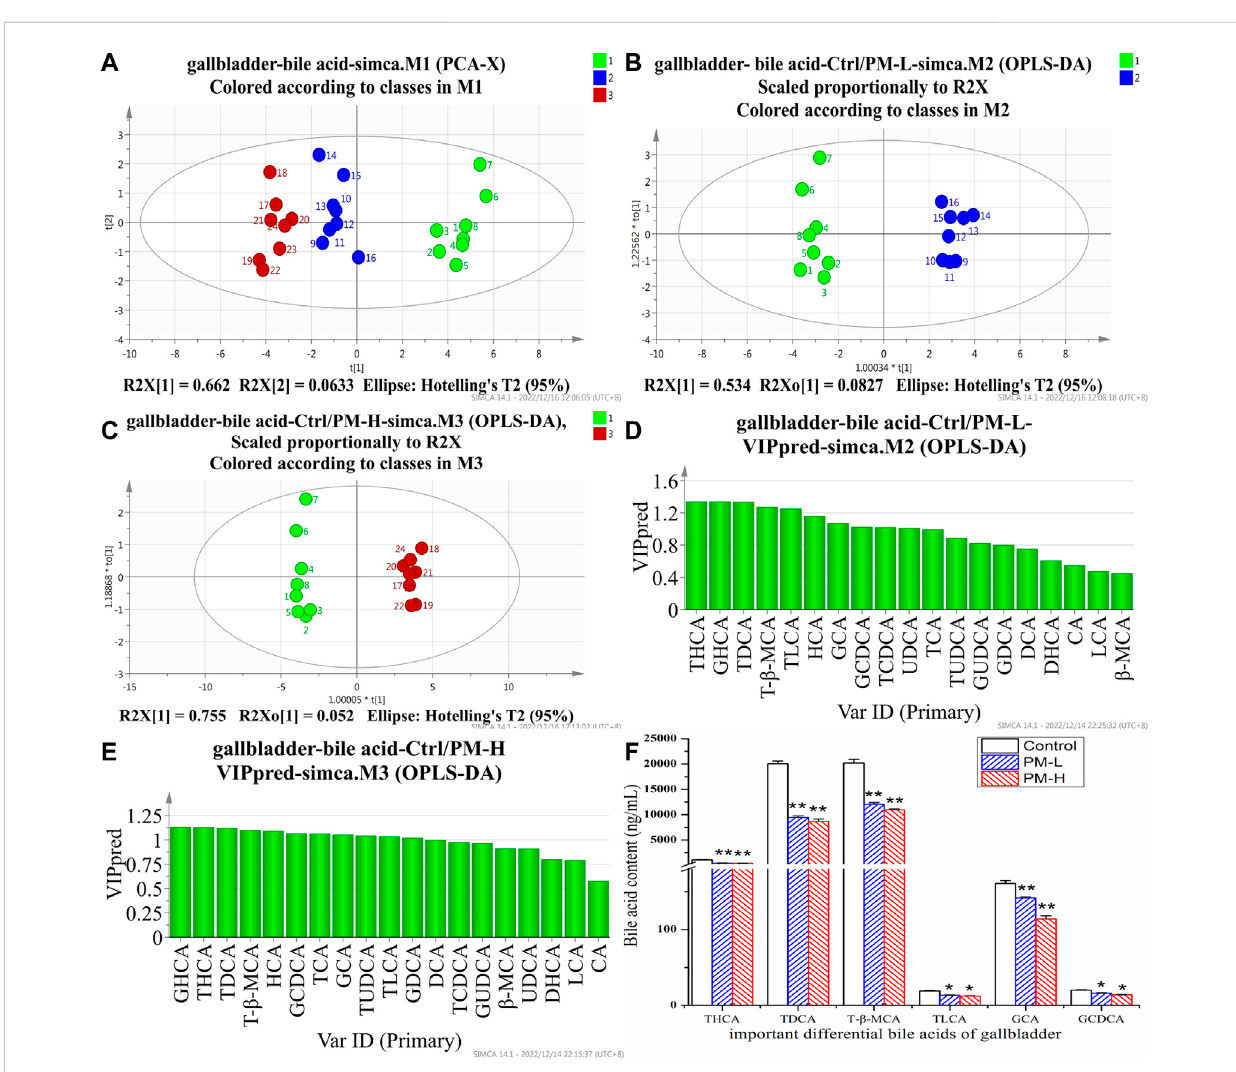
FIGURE 6 Score chart of PCA analysis of 19 bile acids in gallbladder (A) ; core chart and VIP values of OPLS-DA analysis of 19 bile acids in liver (B – E) ; The screened important differential bile acids and their contents (F) . (X± SEM, n = 8, * p < 0.05, ** p < 0.01).